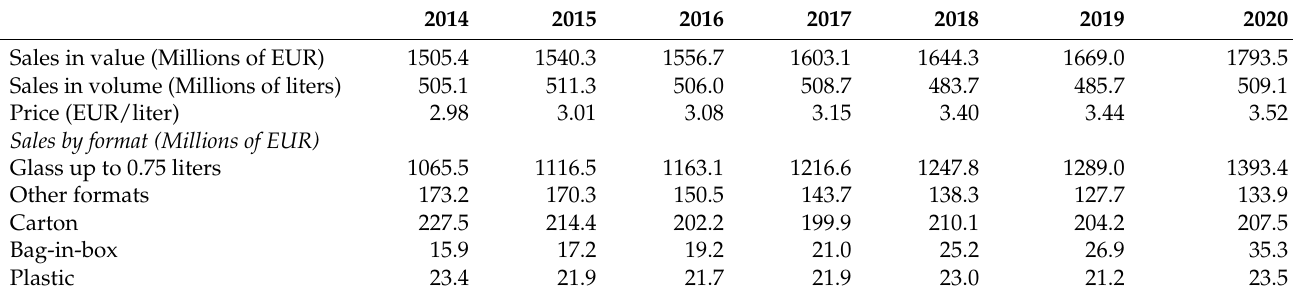
Table 1. Overall picture of the Italian wine market in MMR from 2014 to